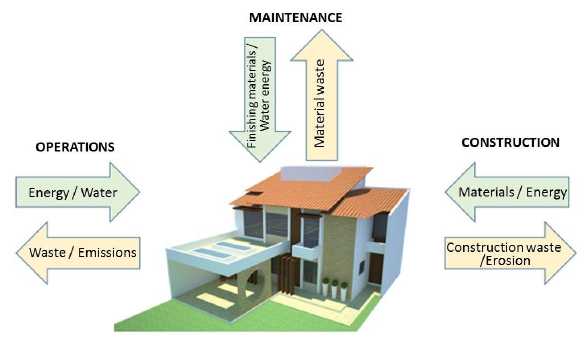
Figure 2: The construction of a building produces several environ- mental effects